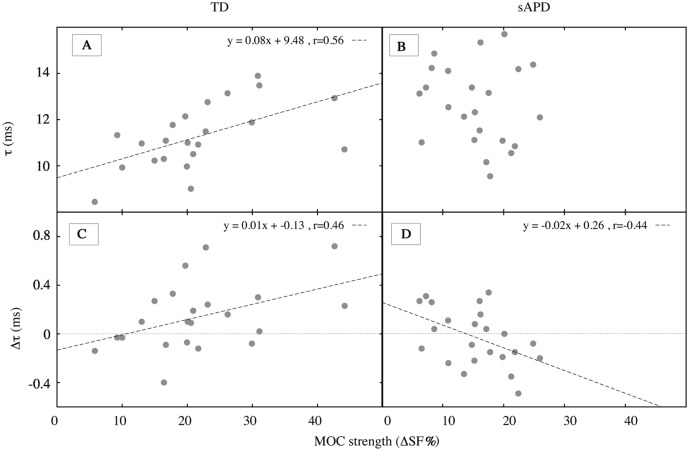
Correlation plots.Panels A and B show correlation between ΔSF and τ for TD and sAPD groups, respectively. Note that the correlation was significant only in the TD group. Panels C and D show correlation between ΔSF and Δτ for TD and sAPD groups, respectively. In panels A, C, and D, dashed diagonal lines represent the relationship between variables in x- and y- axes and their corresponding equations are shown on the top right corner in each panel. In panels C and D, a dotted horizontal line at 0 represents no change in τ due to MOC inhibition. Data points above the line represent increase in SFOAE delay, and data points below the line represent decrease in SFOAE delay due to MOC activation. Notice that most children in TD group are above the 0 change line and the opposite is true in the sAPD group.